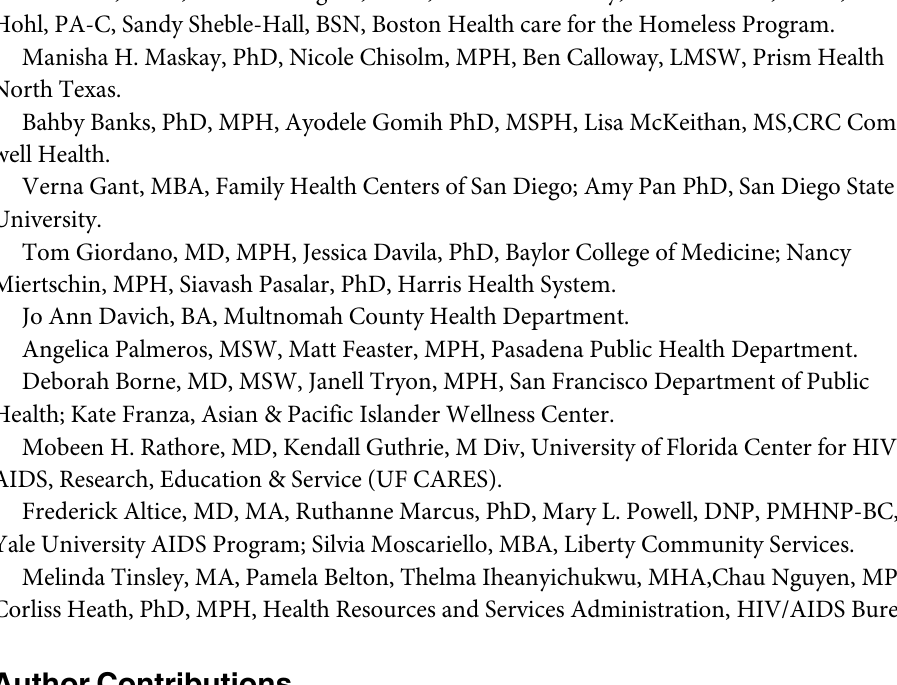
S1 Table. Study sample attrition analysis, HRSA/SPNS Building a Medical Home for Mul- tiply-Diagnosed HIV-positive Homeless Populations initiative from